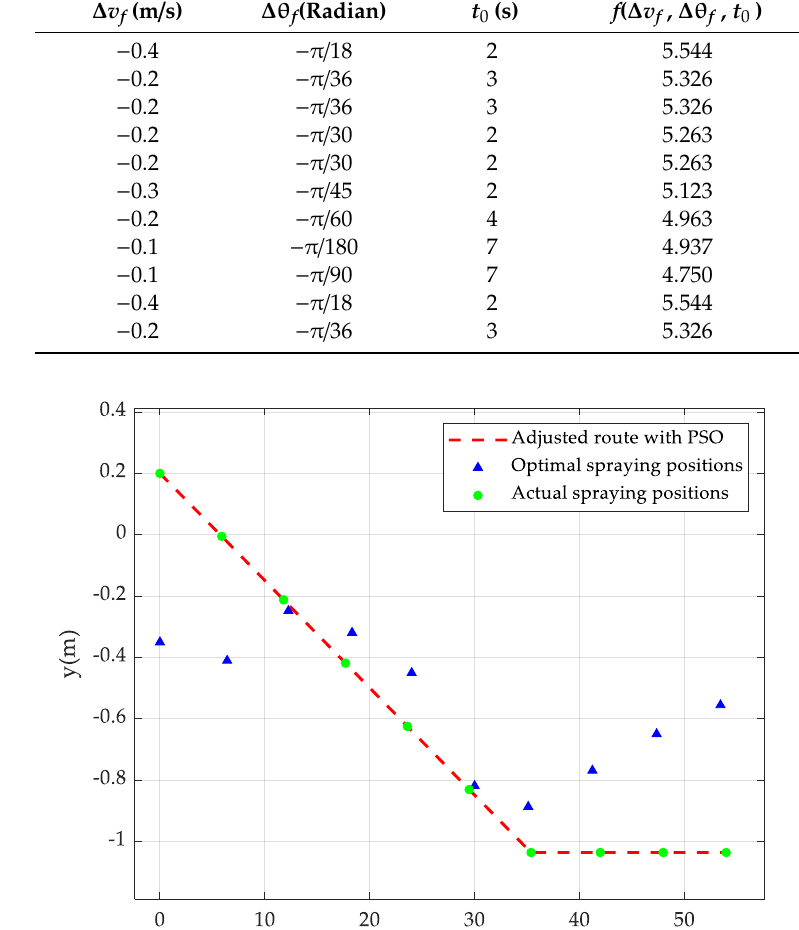
Table 4. Changes in ∆ v f , ∆ θ f , t 0 and f ( ∆ v f , ∆ θ f , t 0 ) in the iterative process.